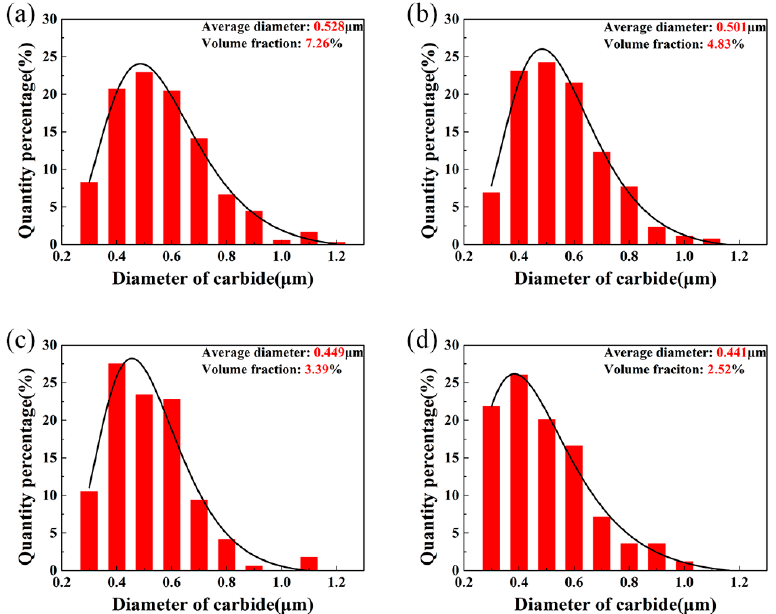
Figure 3. Dimension distributions of spherical carbides after QT with and without CRR under different austenitizing times: Blank/10 specimen ( a ), CRR/10 specimen ( b ), Blank/20 specimen ( c ), and CRR/20 specimen ( d ).